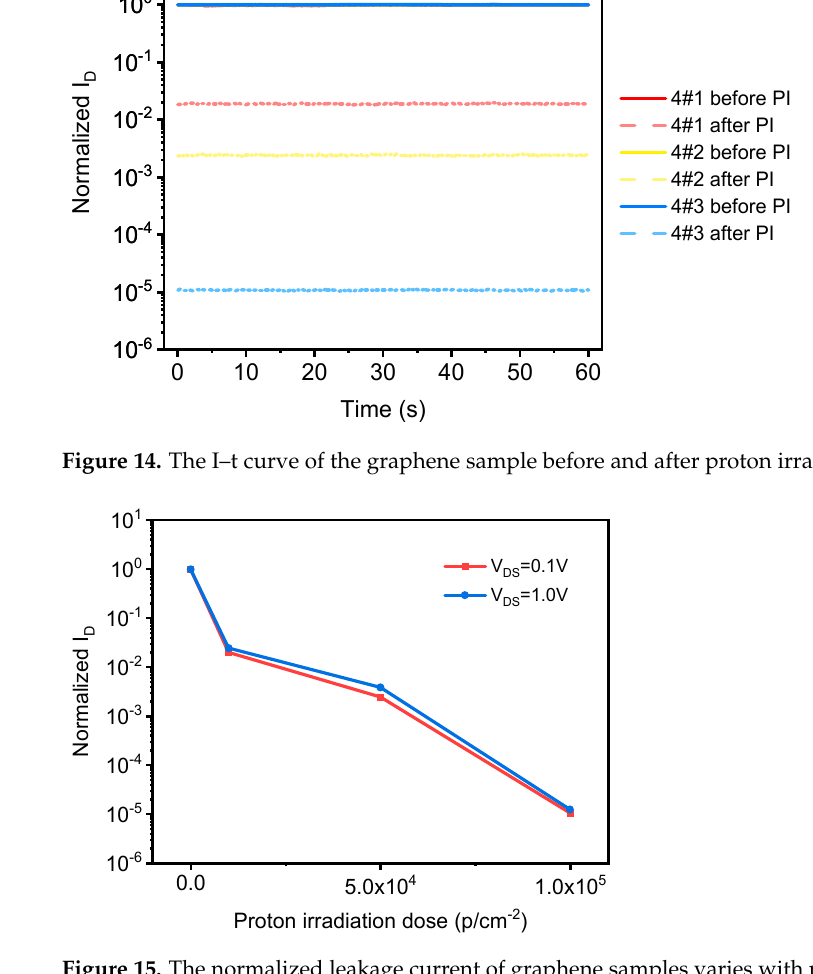
Figure 14. The I–t curve of the graphene sample before and after proton irradiation.